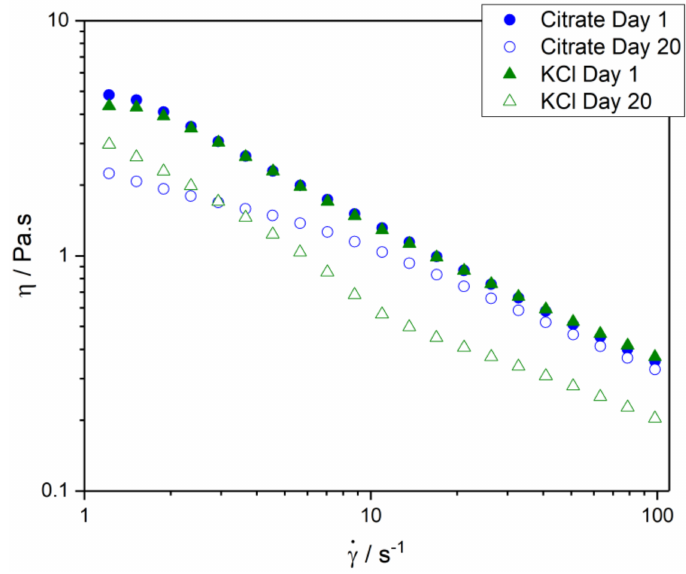
Figure 5. Flow curves between shear rates of 1 and 100 s − 1 for the 0.1 M citrate buffer (blue circles) and 0.35 M KCl (green triangles) emulsions on days 1 (closed symbols) and 20 (open symbols).